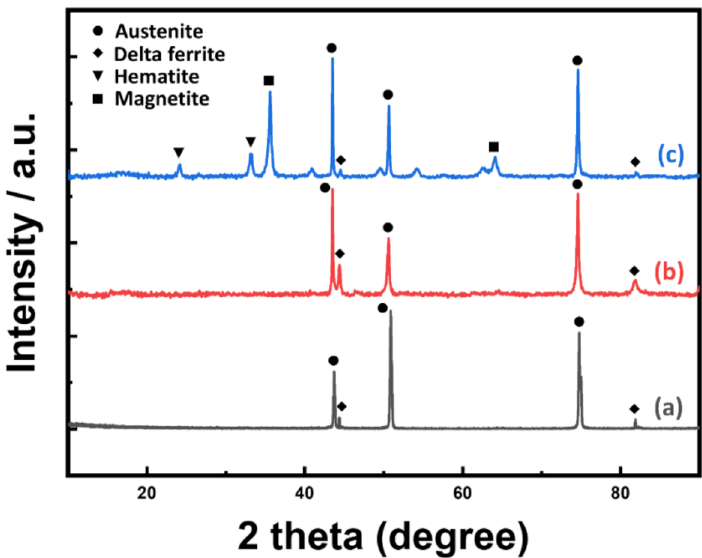
Figure 3. XRD patterns of welded SS ( a ), anodized welded SS ( b ), and heat-treated anodized welded SS ( c ).